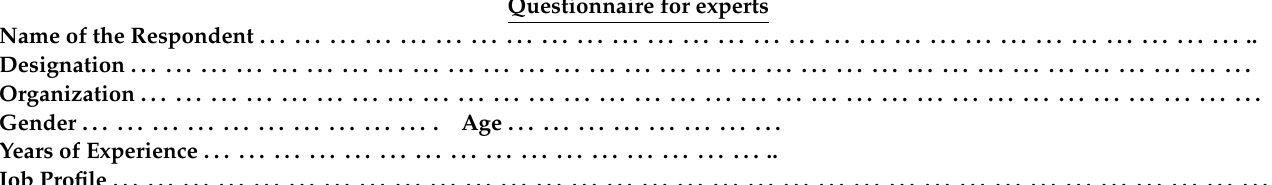
The table is designed to register the perception of the academic professionals regarding the factors for the success of online education in the higher educational institutes. This will help to create a contextual relationship between the factors to decide their driving power and dependence power. Please fill in the white boxes of the Table using one of the following